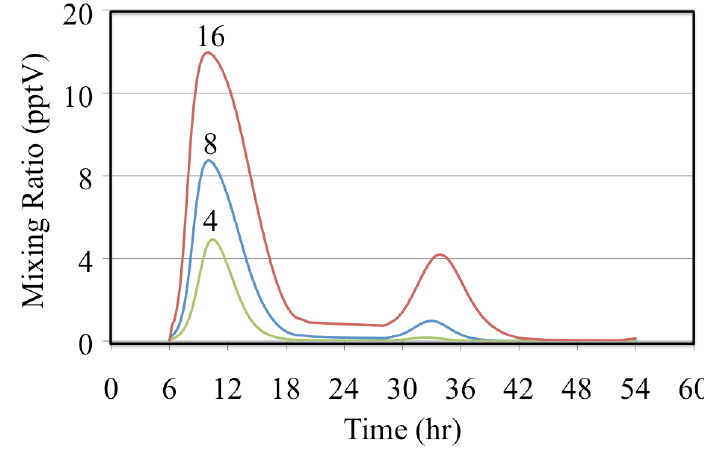
OH-CH O 2• , radical mixing ratios are shown for the ethene cases. The 2 2 ratio in x